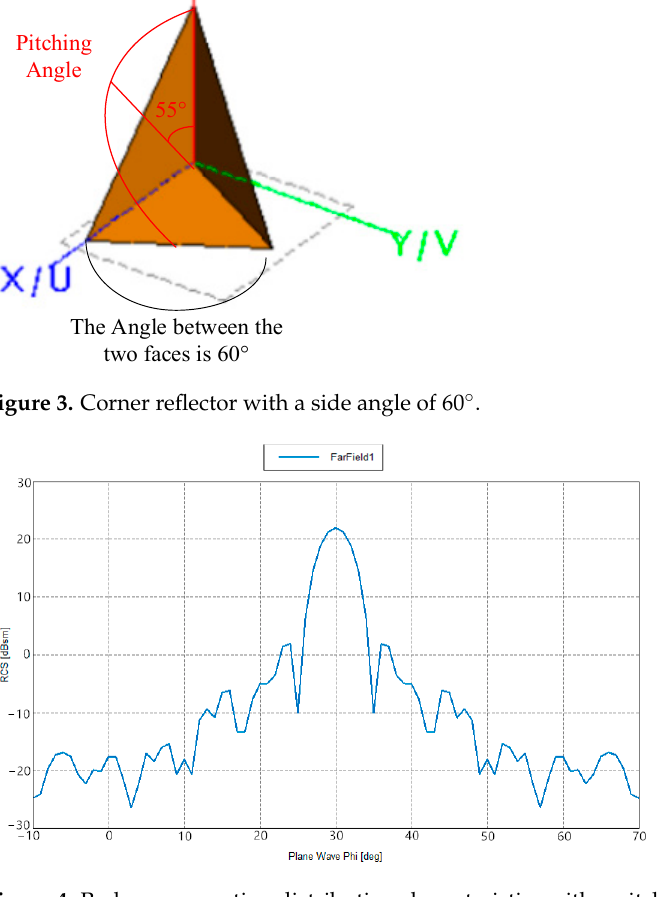
Figure 3. Corner reflector with a side angle of 60°.